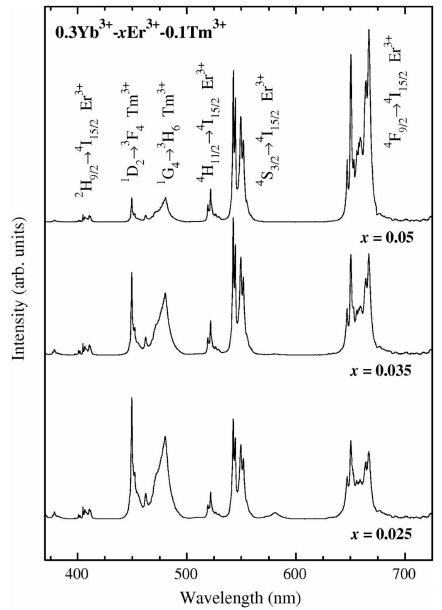
Figure 6. Up-conversion emission spectra of 95SiO 2 -5KYF 4 GCs co-doped with Yb 3+ -Er 3+ -Tm 3+ heat-treated at 700 °C [76].